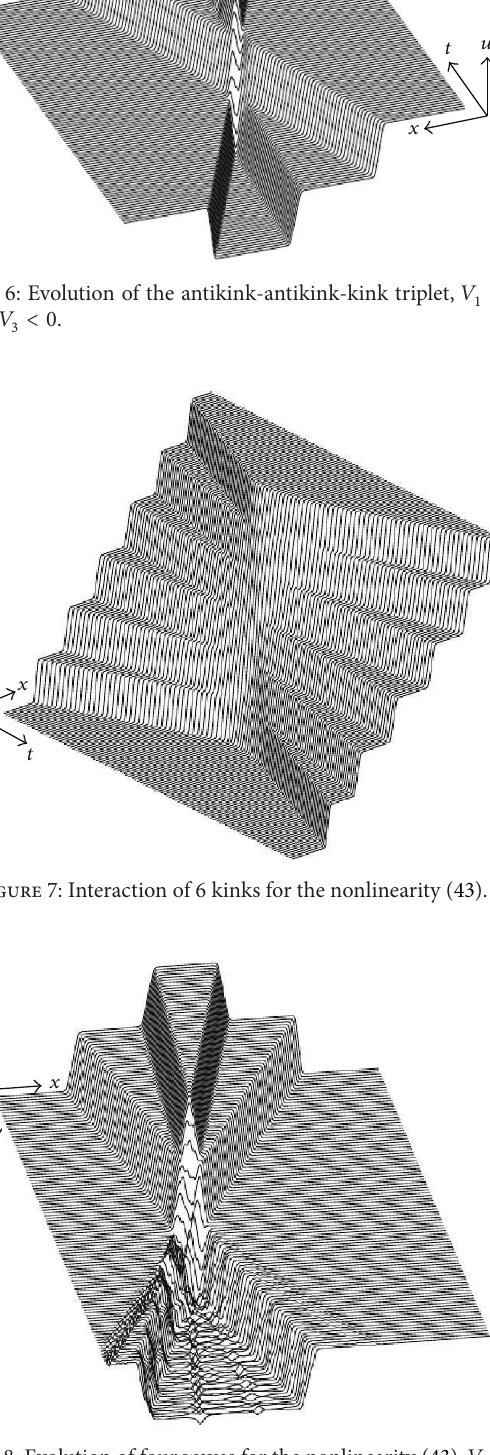
Figure 5: Evolution of the antikink-kink-kink triplet, 𝑉 1 > 0 , 𝑉 2 > < 0 . 0 , 𝑉 3